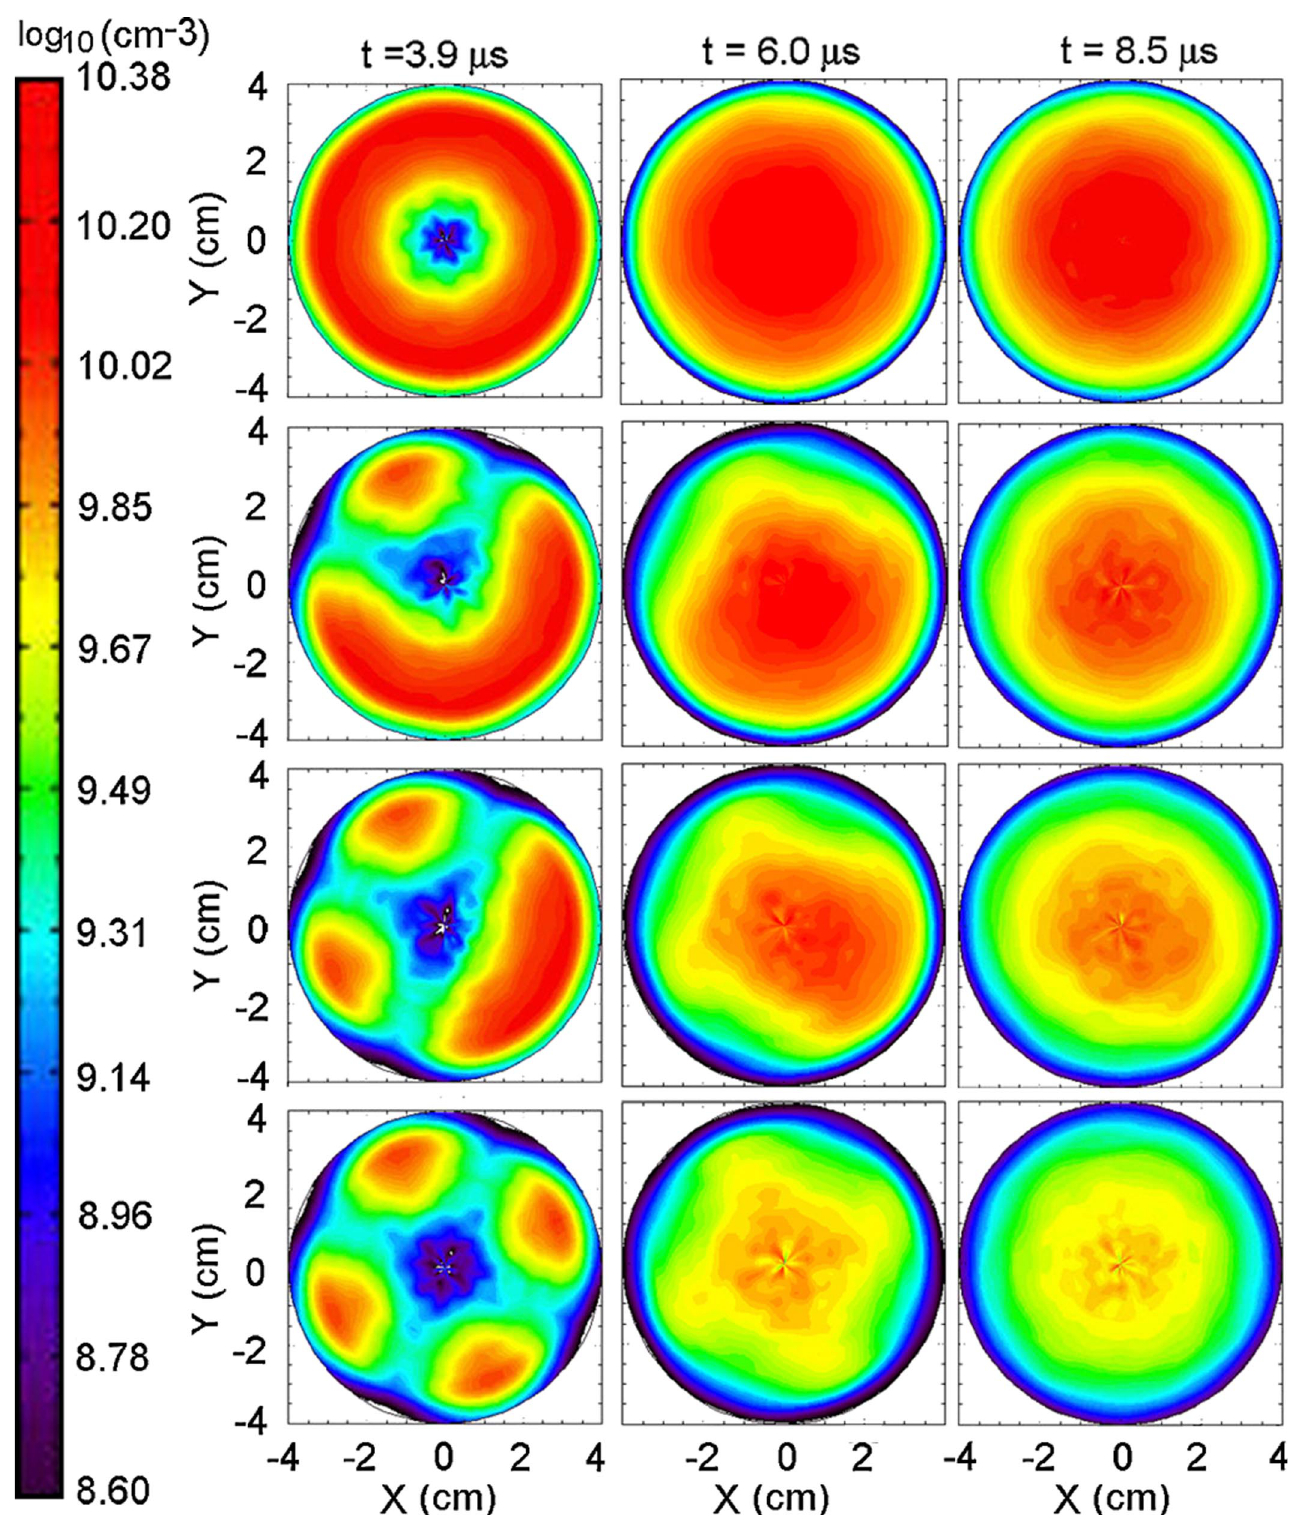
FIG. 14. (Color) f r; (cid:3) g isocontours of n through the midplane of a ceramic segment at t (cid:6) 3 : 9 (cid:1) s (left column), t (cid:6) 6 (cid:1) s (center p column), and t (cid:6) 8 : 5 (cid:1) s (right column). Azimuthal holes of size (cid:2) (cid:3) (cid:6) (cid:2)= 4 approximate nonuniform emission effects: uniform plasma creation (first row), two holes (second row), three holes (third row), and four holes (fourth row). All plots are on the same log